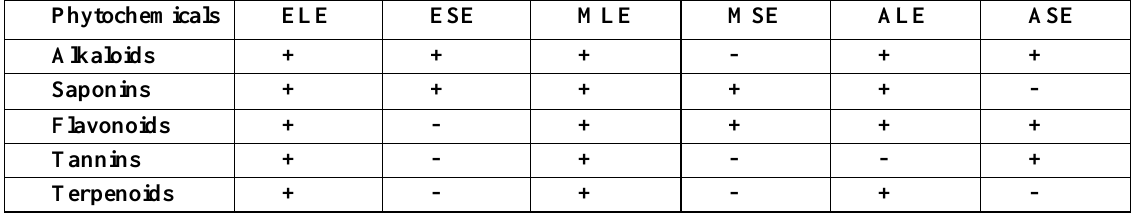
Table 1. Phytochemical constituents of leaf and stem bark extracts of A. digitata. Phytochemicals